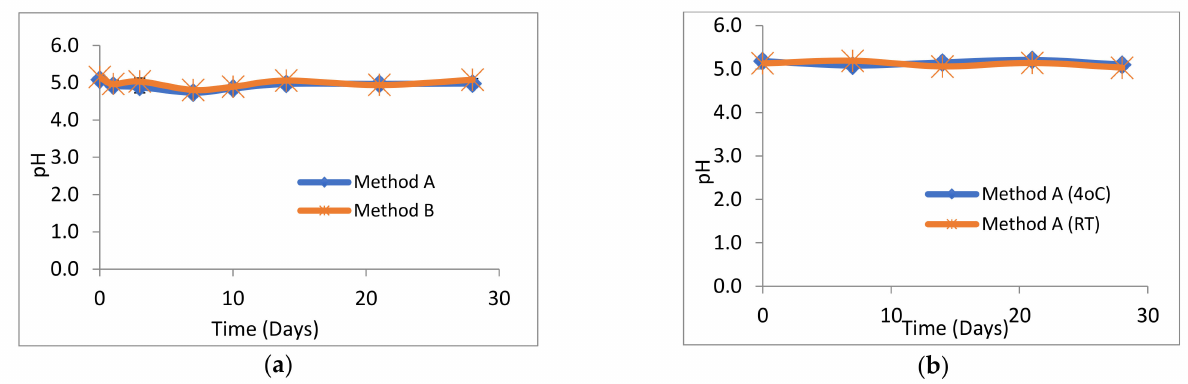
Figure 2. pH of losartan suspensions stored over 28 days. ( n = 3, ± SD, p > 0.05) ( a ) prepared by methods A and B and stored at 4 ◦ C, ( b ) prepared by method A and stored at 4 ◦ C or room temperature (RT).